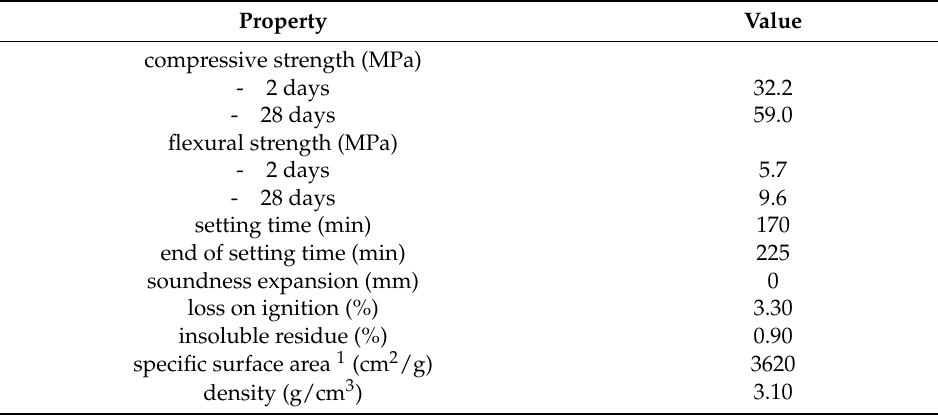
Table 2. Main properties of cement used for tests.